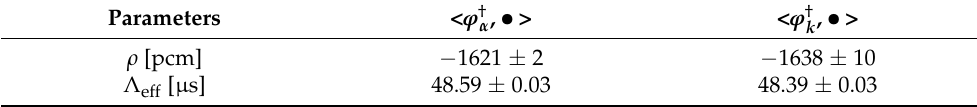
Table 23. Effective kinetics parameters for the H2 configuration without delayed